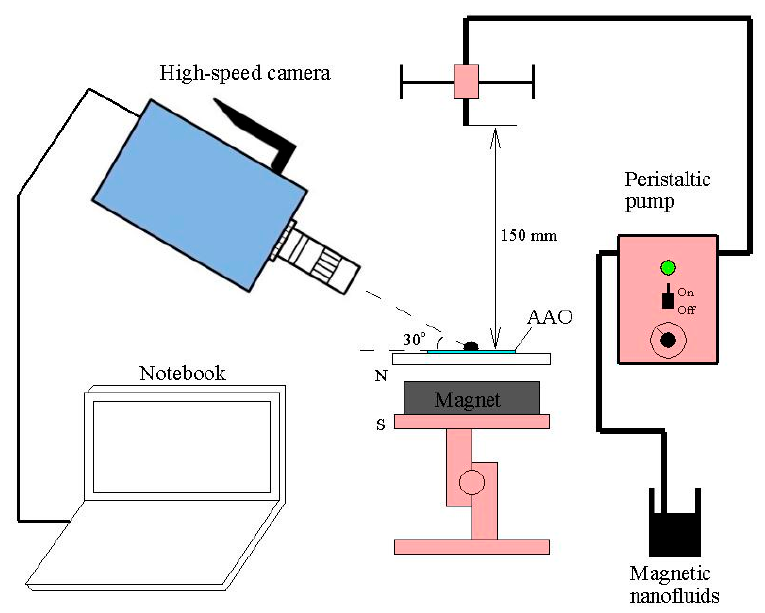
Figure 1. Schematic diagram of the experimental setup.